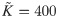
Probability of extinction of small stochastic populations.Probability of extinction in terms of the initial population size around L for deterministic (σ = 0) and demographic stochastic (σ = 1) uncontrolled populations and populations controlled with different intensities by ALC (A) and ATH (B). Calculations are based on Models (1) and (2) with r = 4.5, K˜=400 and s = 0.002 (L ≈ 6.015). For a given initial population size, the probability of extinction has been obtained for the first 100 generations and over 1000 replicates.